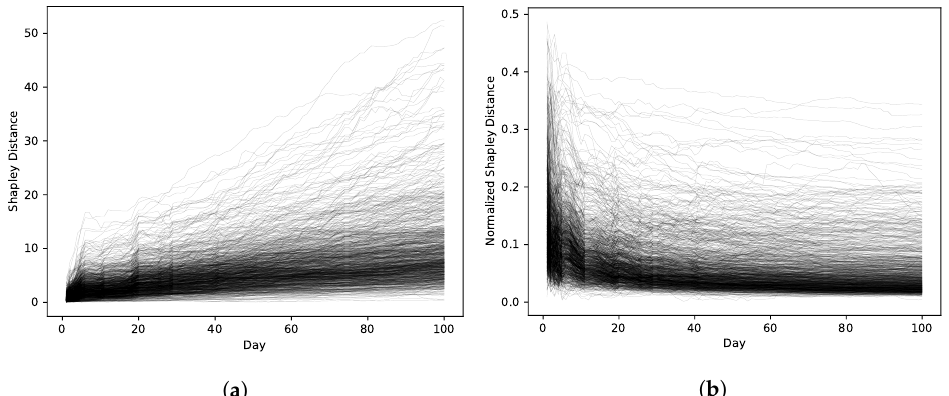
Figure 5. Progress of Shapley distance ( a ) and normalized Shapley distance ( b ) with nucleolus for 1000 trials.